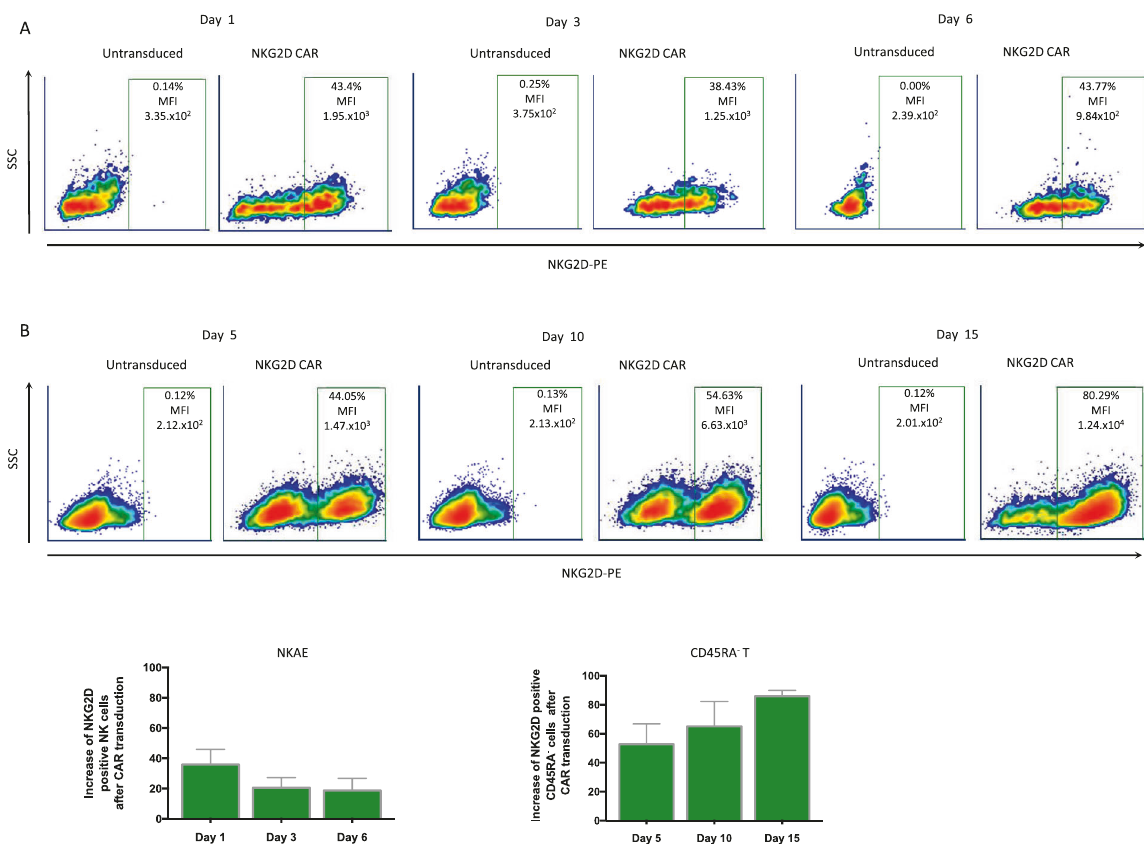
Fig. 2 NKG2D-CAR transduction. NKAE cells and CD45RA − T cells were transduced with an NKG2D-CAR. Representative dotplots are shown for NKAE cells ( A ) and CD45RA − T cells ( B ) transduction. Both cell types showed increased percentages of NKG2D-positive cells (over